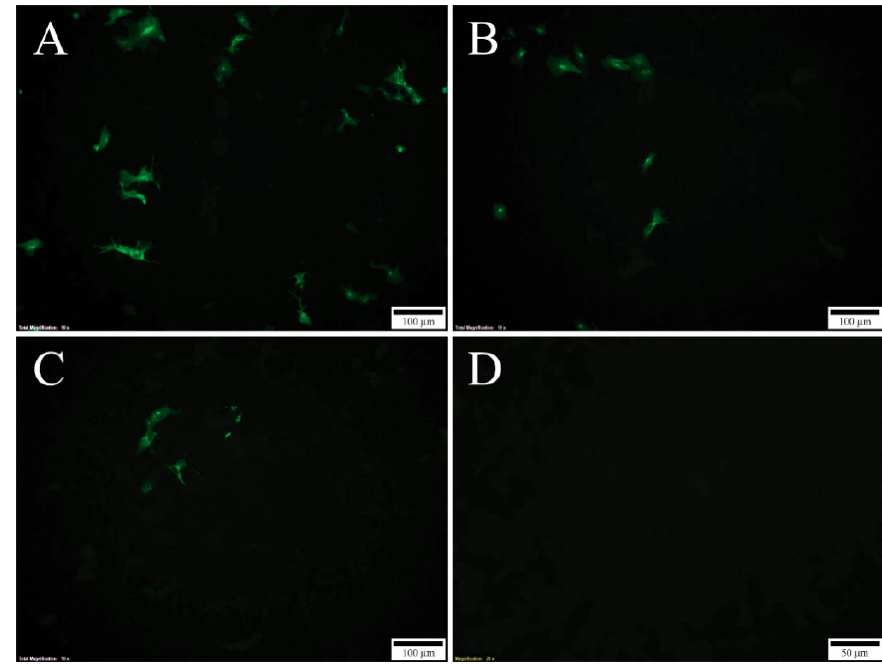
Figure 3. Indirect fluorescent antibody test (IFAT) using mAB targeting E2 in transfected Chinook salmon embryo cells (CHSE) cells: 4 dpt (10X). ( A ) rSAV3, ( B ) rSAV3 E2 319G , ( C ) rSAV3 E2 319A ., ( D ) negative control. No staining was observed in the cells transfected with constructs containing E1 35 mutations (not shown).